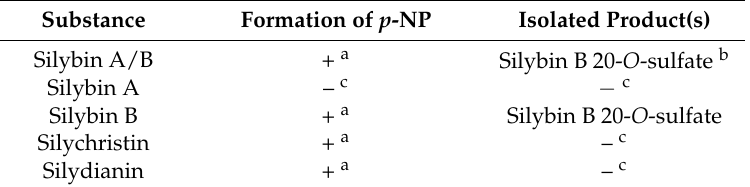
Table 1. Overview of aryl sulfotransferase from rat liver (AST IV) substrate specificity and isolated sulfated